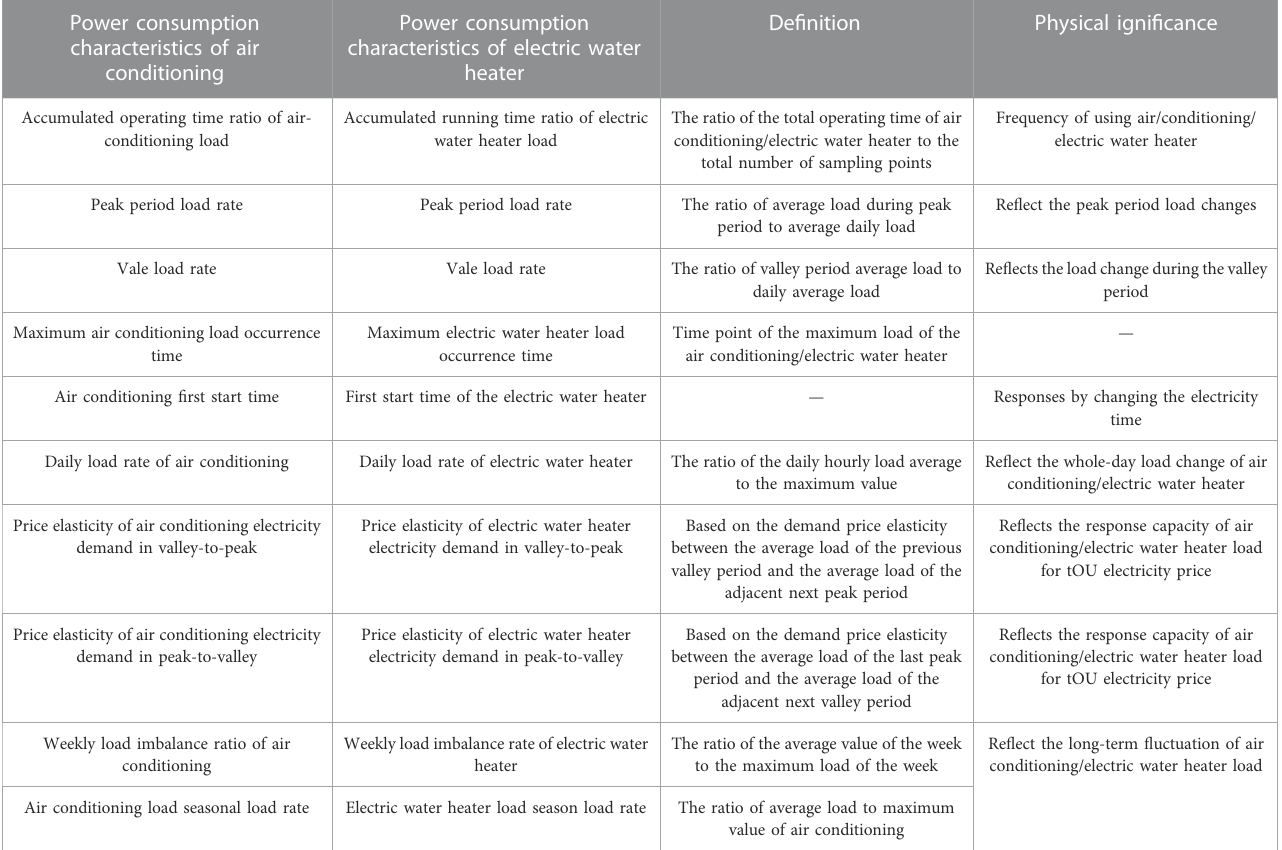
TABLE 2 Preliminary set of power consumption characteristics of high-energy-consuming